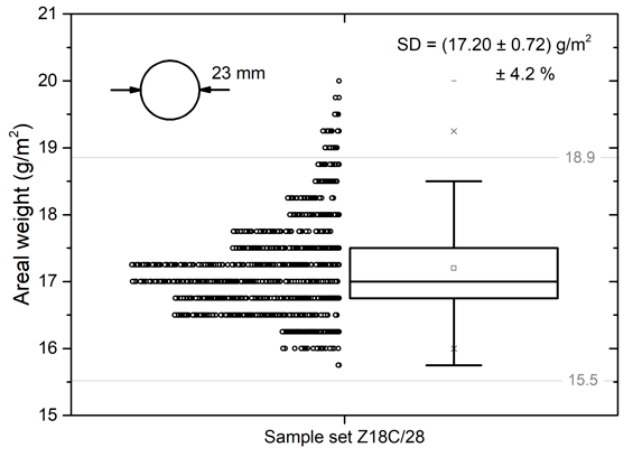
Figure 7. Area weights of all the cut-out pieces.